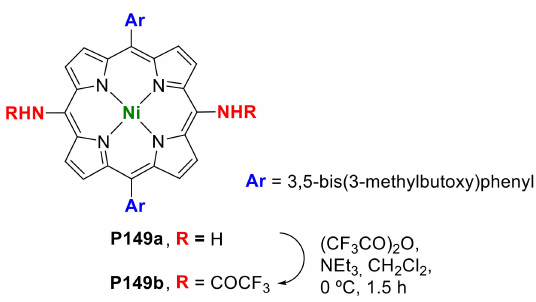
Figure 13. Structures of the Ni(II) complex of meso -substituted diaminoporphyrin P149a and the corresponding bis(trifluoroacetamide) P149b